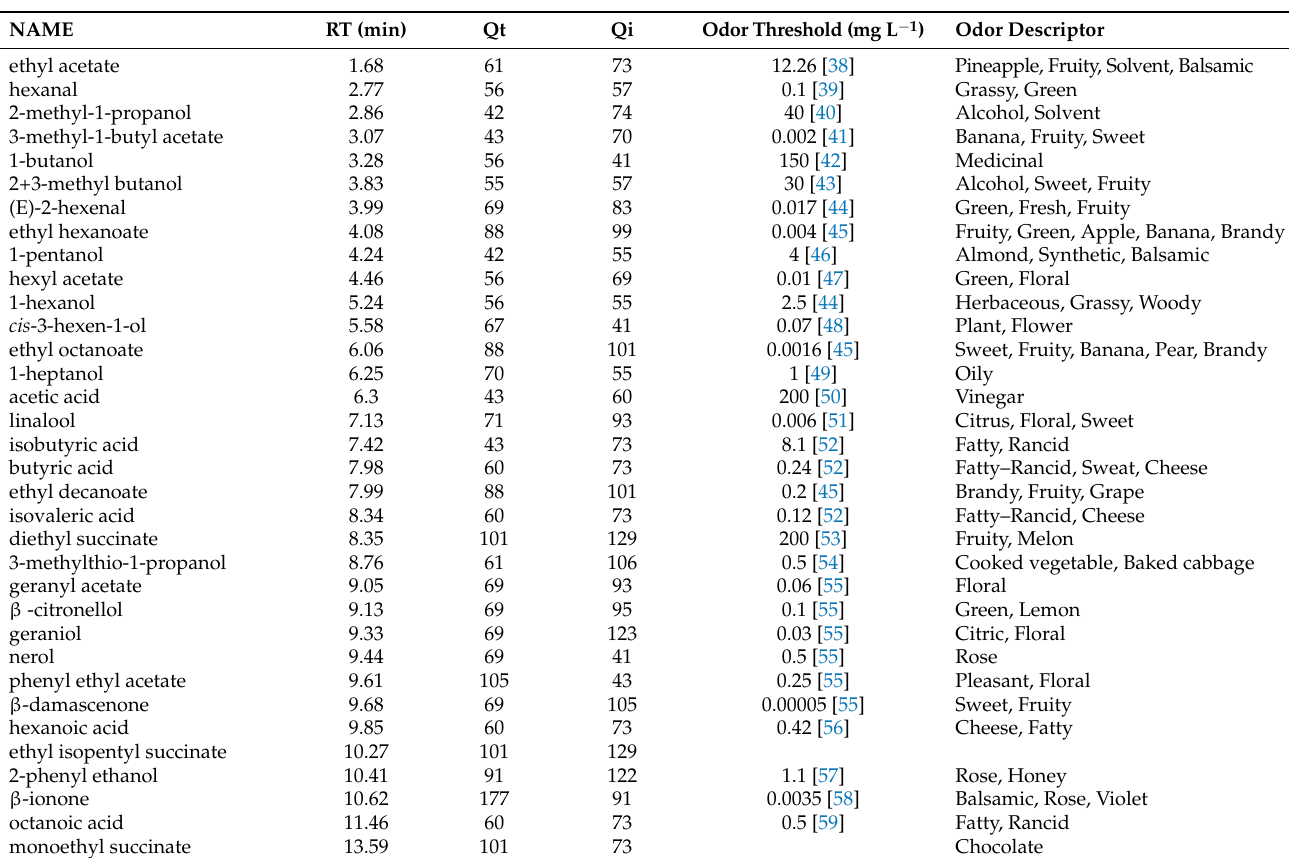
Table 1. Retention time (RT), quantifier ion (Qt), qualifier ion (Qi), odor threshold (mg L − 1 ), and the odor descriptor of the identified VOC in wine